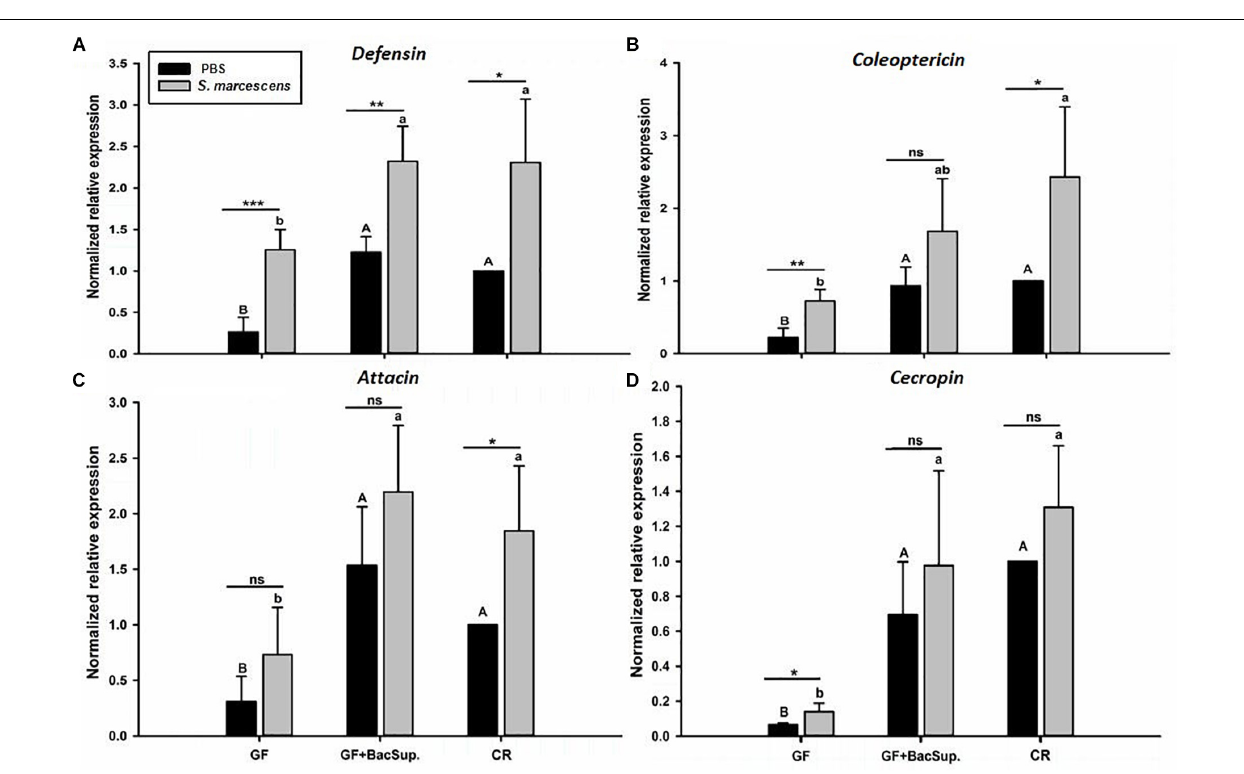
FIGURE 9 | The effect of bacterial challenge on the expression level of antimicrobial peptide genes in fat body of symbiotic (GF BacSup and CKR) and aposymbiotic (GF) RPW larvae. Uppercase and lowercase letters indicate the statistical differences across control and bacteria challenge groups, respectively. “ ∗ ” presents the significance within each cohort ( t -test: ns, P > 0.05, ∗ P < 0.05, ∗∗ P < 0.01, ∗∗∗ P < 0.001). Error bars represent the standard deviation of four independent replicates. The data was log10 transformed to meet the normality assumptions. The transcript copies of Defensin (A) , Coleoptericin (B) , Attacin (C) and Cecropin (D) were determined by